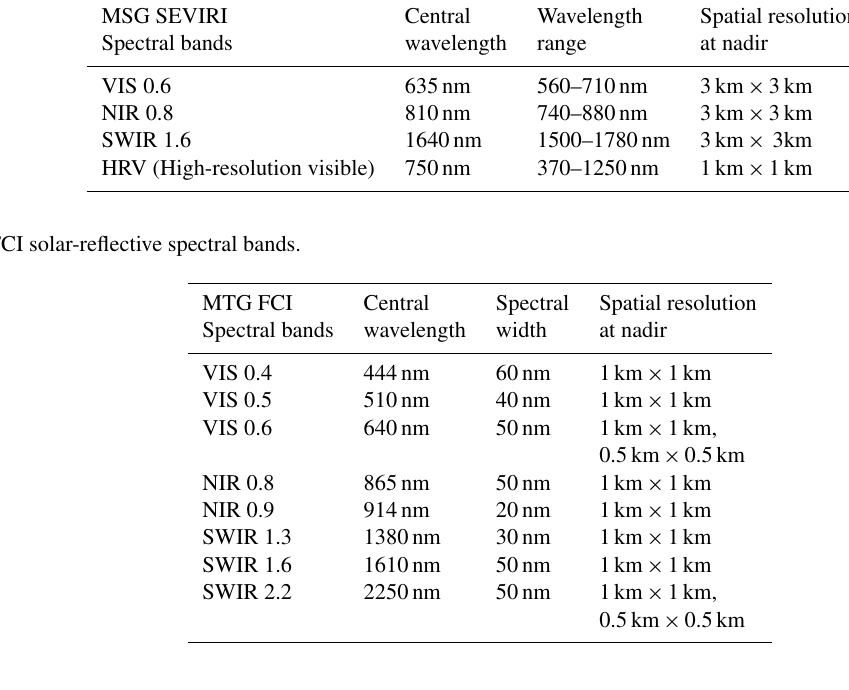
Table 1. MSG SEVIRI solar-reflective spectral bands. MSG SEVIRI Central Wavelength Spatial resolution Spectral bands wavelength range at nadir